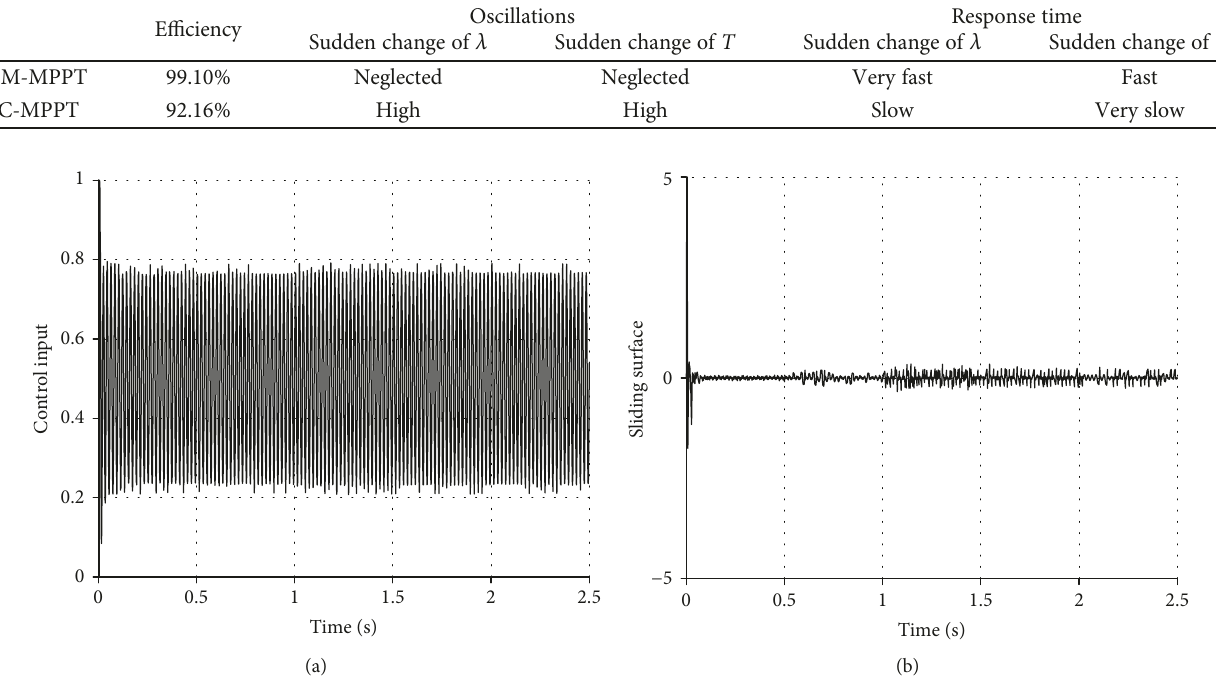
Table 3: Performance comparison between the SM-MPPT and the IC-MPPT.